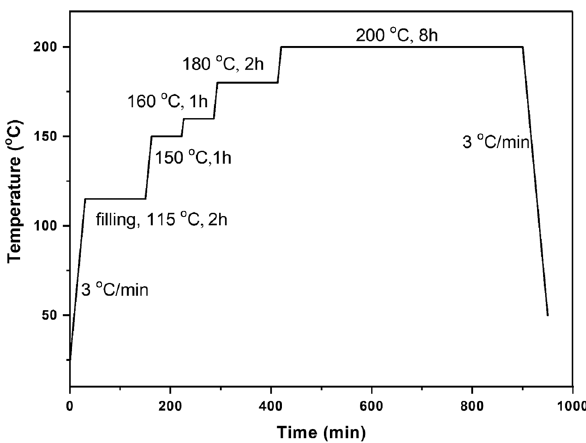
Figure 1: The manufacturing process of